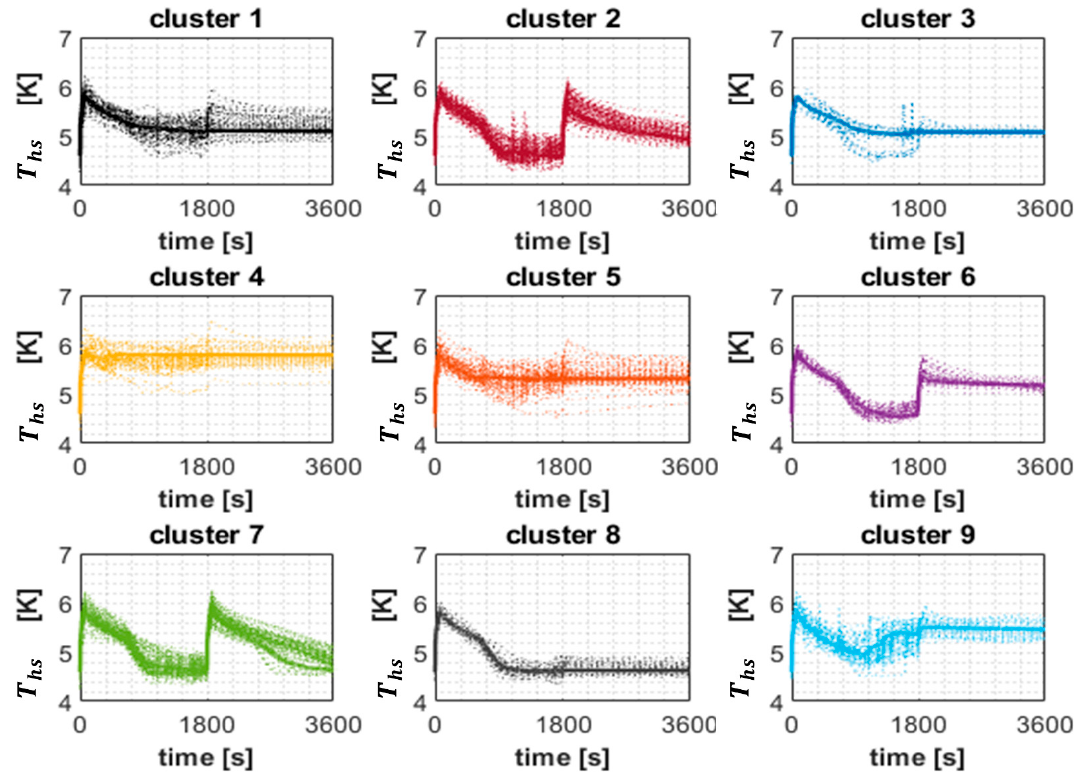
Figure A2. Nine clusters of (cid:1868) (cid:3004)(cid:3020)(cid:3014),(cid:3036)(cid:3041) transient scenarios generated by POD-based Kriging metamodels.